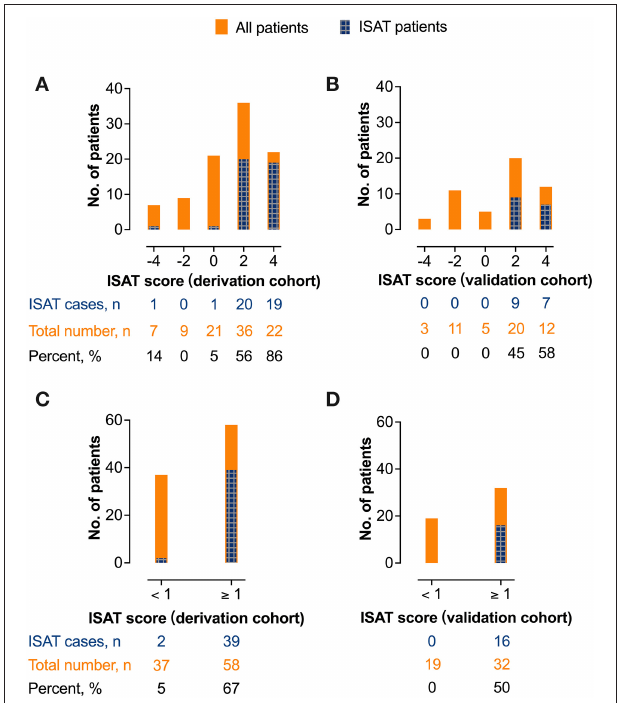
FIGURE 3 | The distributions and percentages of in situ atherosclerotic thrombosis patients in different predictive scale risk categories. (A) The derivation cohort (consecutive). (B) the validation cohort (consecutive). (C) the derivation cohort (dichotomous). (D) the validation cohort (dichotomous). ISAT, in situ atherosclerotic thrombosis.